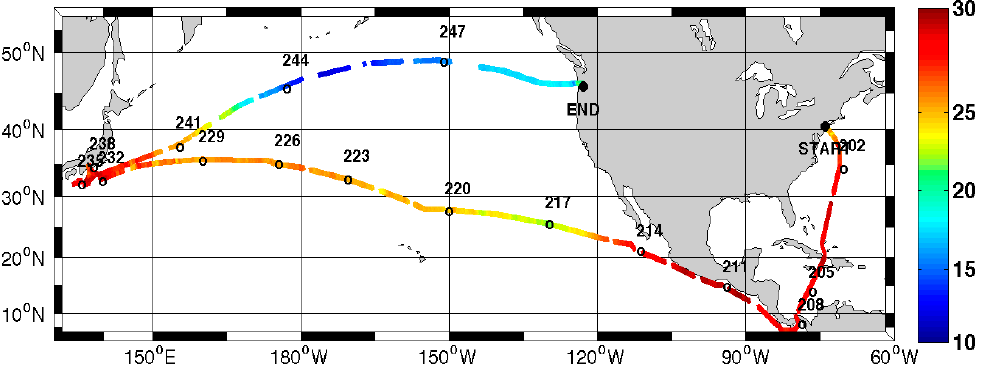
Figure 6. SST skin measured by an Infrared Sea-surface temperature Autonomous Radiometer (ISAR) on the M/V Andromeda Leader from 19 July to 5 September 2016. The numbers of on the ship track are days of the year, and the colors indicate temperature as indicated at right in °C. Gaps in the tracks indicate where measurements were automatically suspended during rain.